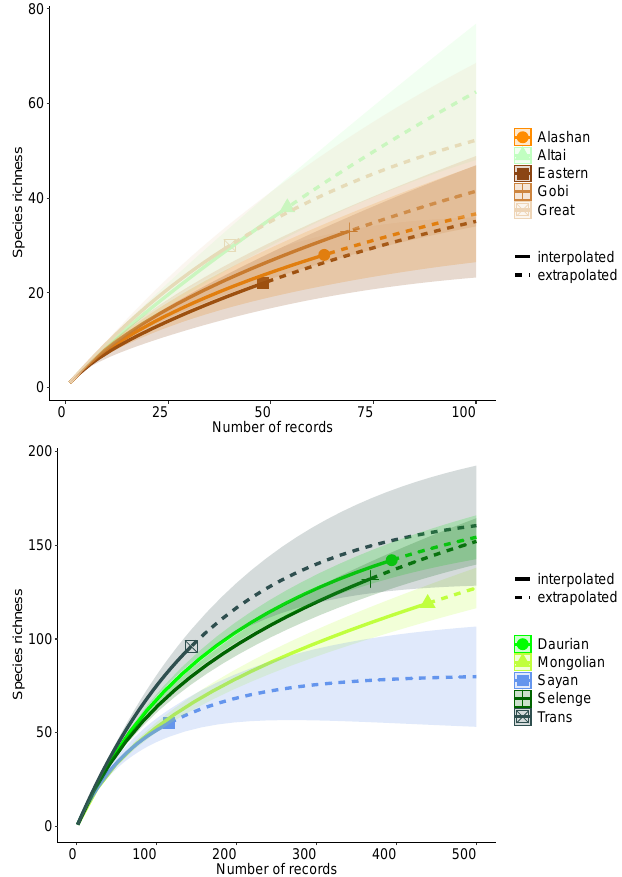
Figure 5. Sampling unit-based interpolation and extrapolation curves of ecoregions with 0.95 confidence interval. Axes X and Y axes represent the number of records and species richness, respectively. Ecoregions are jointly drawn on plots according to their grouping in the NMDS graph (Figure 6). Colors refer to the map in Figure 1. Ecoregion abbreviations as in Figure 4.